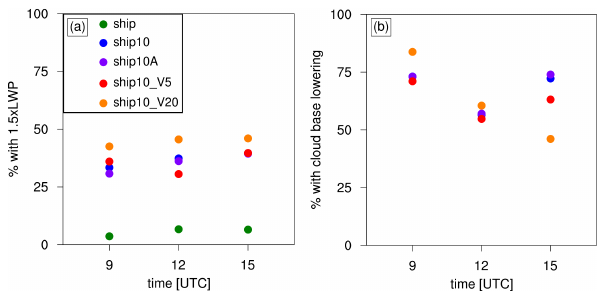
Figure 10. (a) Percentage of ship plume points of significant cloud response determined as in Fig. 7, where at least a 50% liquid water path (LWP) increase was detected. Given a 50% LWP increase in at least 25% of all plume points, the percentage of plume perturbed grid points which additionally displayed a cloud base lowering was computed and is shown in (b) . A cloud base lowering is diagnosed for any change greater than 0m. Note that a cloud base lifting was not detected at any